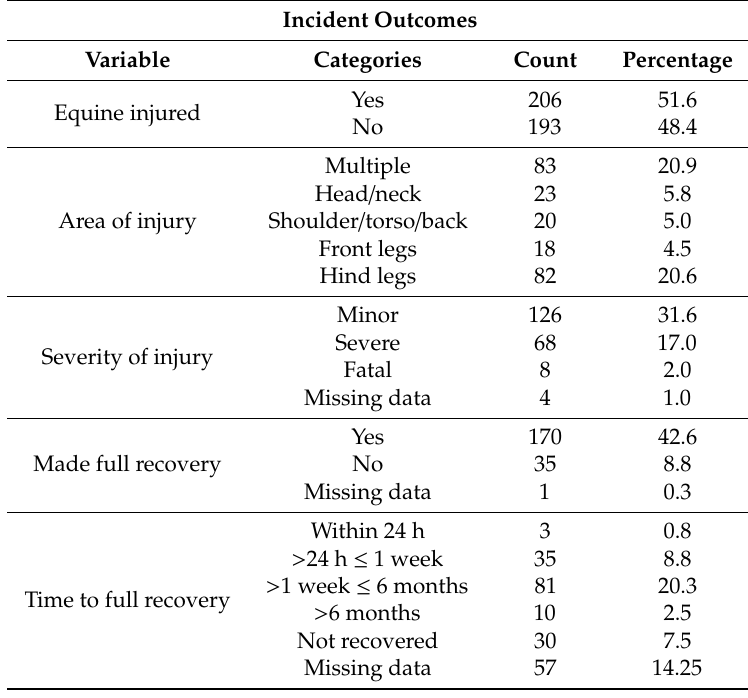
Table 9. The counts and percentage breakdown of incident outcomes (equine injury and recovery) in relation to the 399 incidents reported by survey respondents (n =